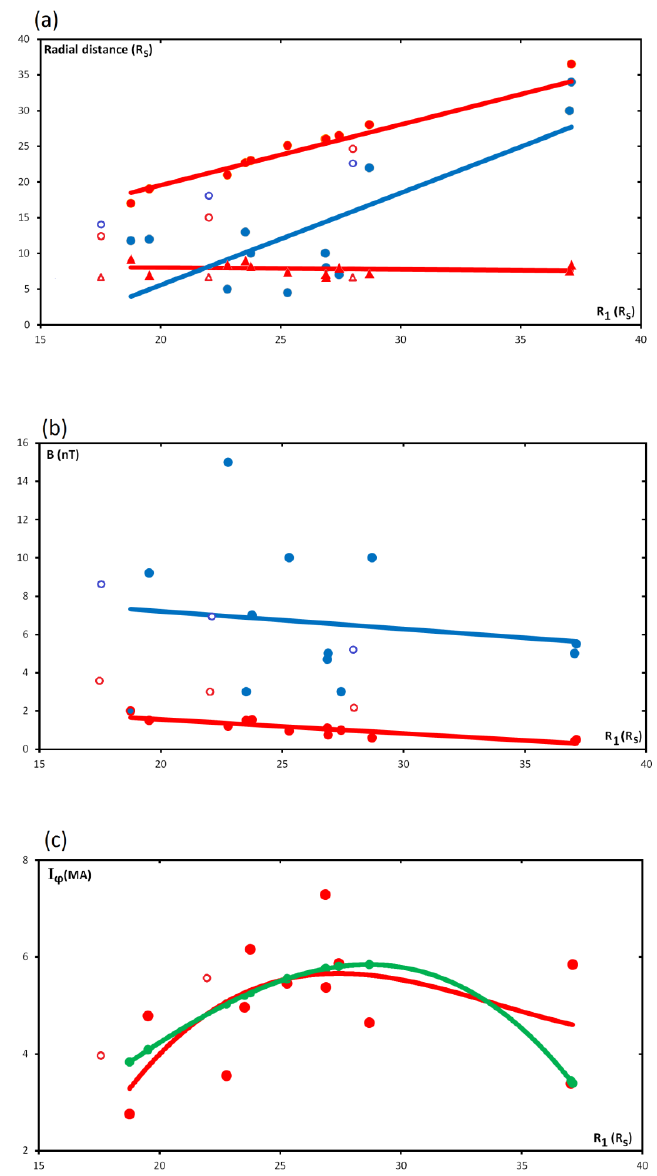
Figure 5. “Selected” model parameters for each pass as given in Table 3 are shown plotted versus the estimated distance to the subsolar magnetopause R 1 ( R S ) on each pass, together with least-squares fitted lines. Panel (a) shows the radial distance parameters of the model, where the filled red circles and triangles show the outer and inner boundaries of the ring current R rc and R rc , respectively, while the filled 1 2 blue circles show the radial distance of the inner edge of the tail current R 2 . The red and blue lines then show linear least squares fits to these data, given by Eqs. (4a)–(4c). The corresponding open symbols show the parameters corresponding to the models proposed by Belenkaya et al. (2008) given in Table 1, which are not included in the fits. Panel (b) similarly shows the model field parameters, where the filled red circles show the ring current field strength B rc and the filled blue circles the tail field parameter B t . Least squares linear fits are shown by the 1 red and blue lines, as given by Eqs. (4d) and (4e), while the open symbols again show the values of the Belenkaya et al. (2008) parameters given in Table 1, not included in the fits. Panel (c) shows the total ring current values I ϕ for each pass given by Eq. (2) using the selected fit parameters (red circles) to which a third order polynomial has been fitted (red line), given by Eq. (5a). The green circles show the total ring current values determined from the linear approximation fit parameters (also given in Table 3), for which the corresponding third order fit (green line) is given by Eq. (5b). The open red circles again show the values corresponding to the Belenkaya et al. (2008) parameters given in Table 1, though the value for the expanded model is off-scale at ∼ 14MA and has been